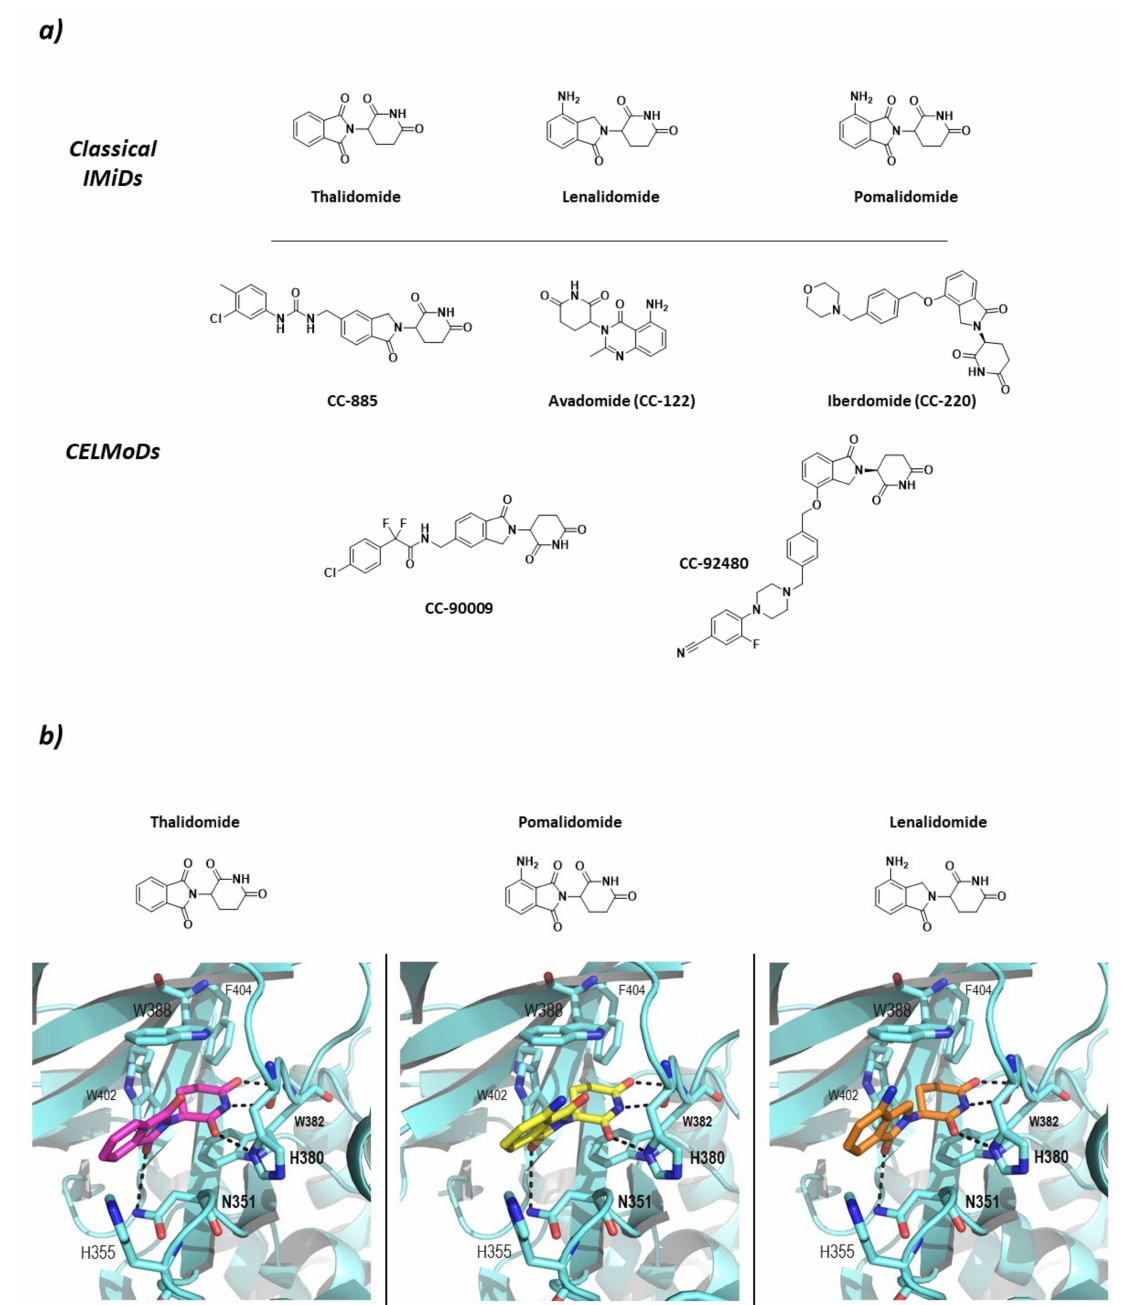
Figure 6. Classical ImiDs and CELMoDs ( a ) 2D representation of the structures of the Classical ImiDs and CELMoDs reported to date that have reached clinical trials. ( b ) 3D representation of the binding mode to CRBN (blue) of the classical ImiDs: thalidomide (magenta), pomalidomide (yellow), and lenalidomide (orange) as found in PDB codes 4CI1, 4CI3, and 4CI2, respectively. Hydrogen bonds are shown as dashed